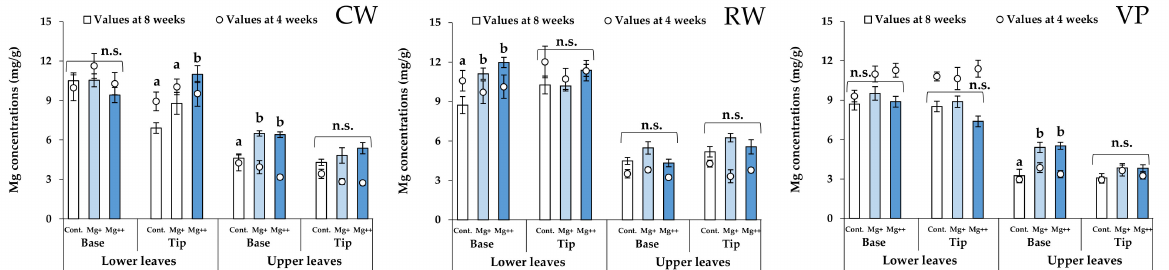
Figure 5. Mg concentrations in the base and tip of the lower and upper leaves in each treatment group and each cultivar at 4 (scatter plots) and 8 weeks (bar graph). Data are means ± SE. Significant differences among means are indicated by different letters. n.s. represents no significant differences among the treatment groups. Cultivars: Celeb Wine (CW), Reina White (RW), and Voyage Peach